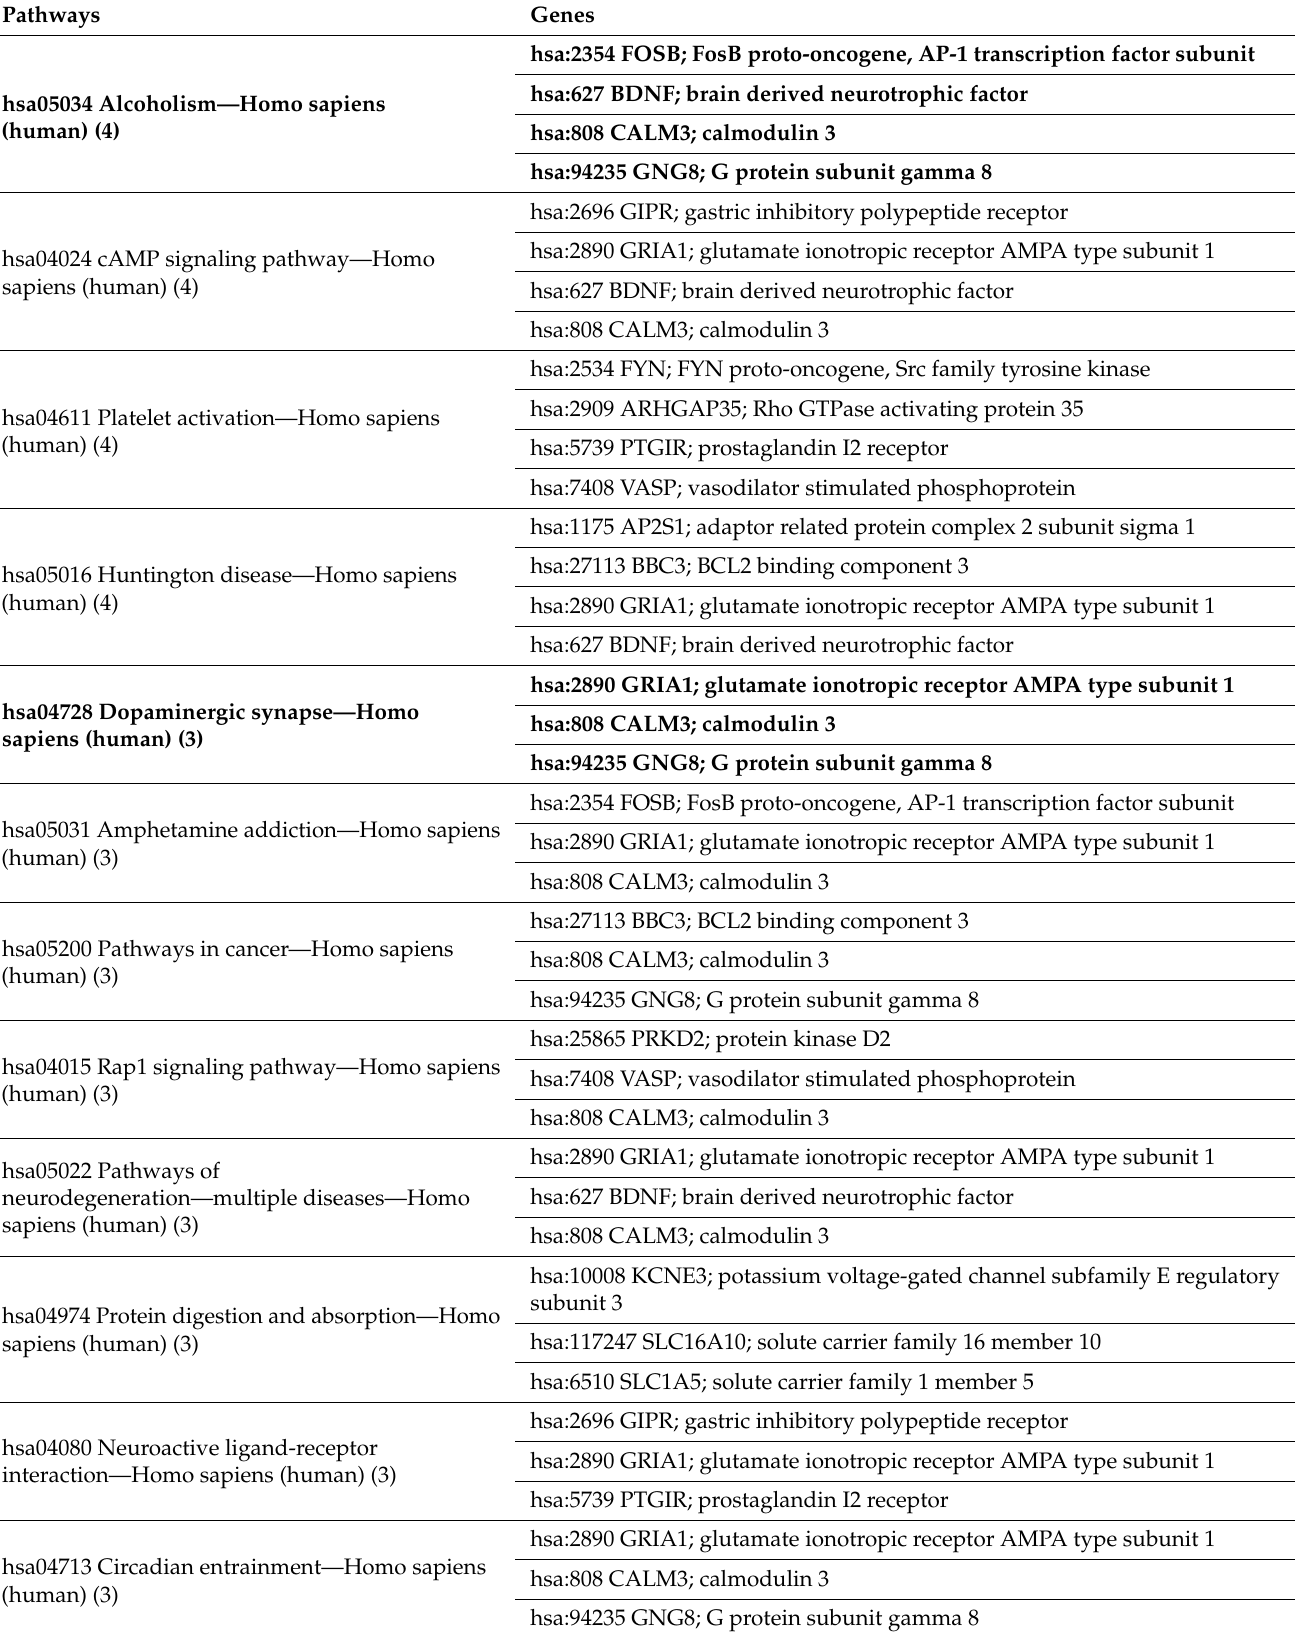
Table 4. KEGG Mapper search results for the 80 coding genes discovered in this